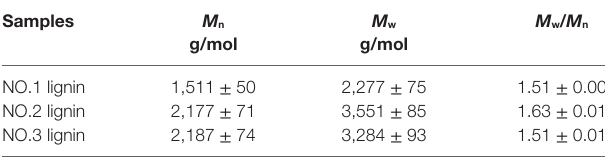
Table 1 | Weight-average ( M w ), number-average ( M n ) molecular weights and polydispersity indexes ( M w / M n ) of the three lignin